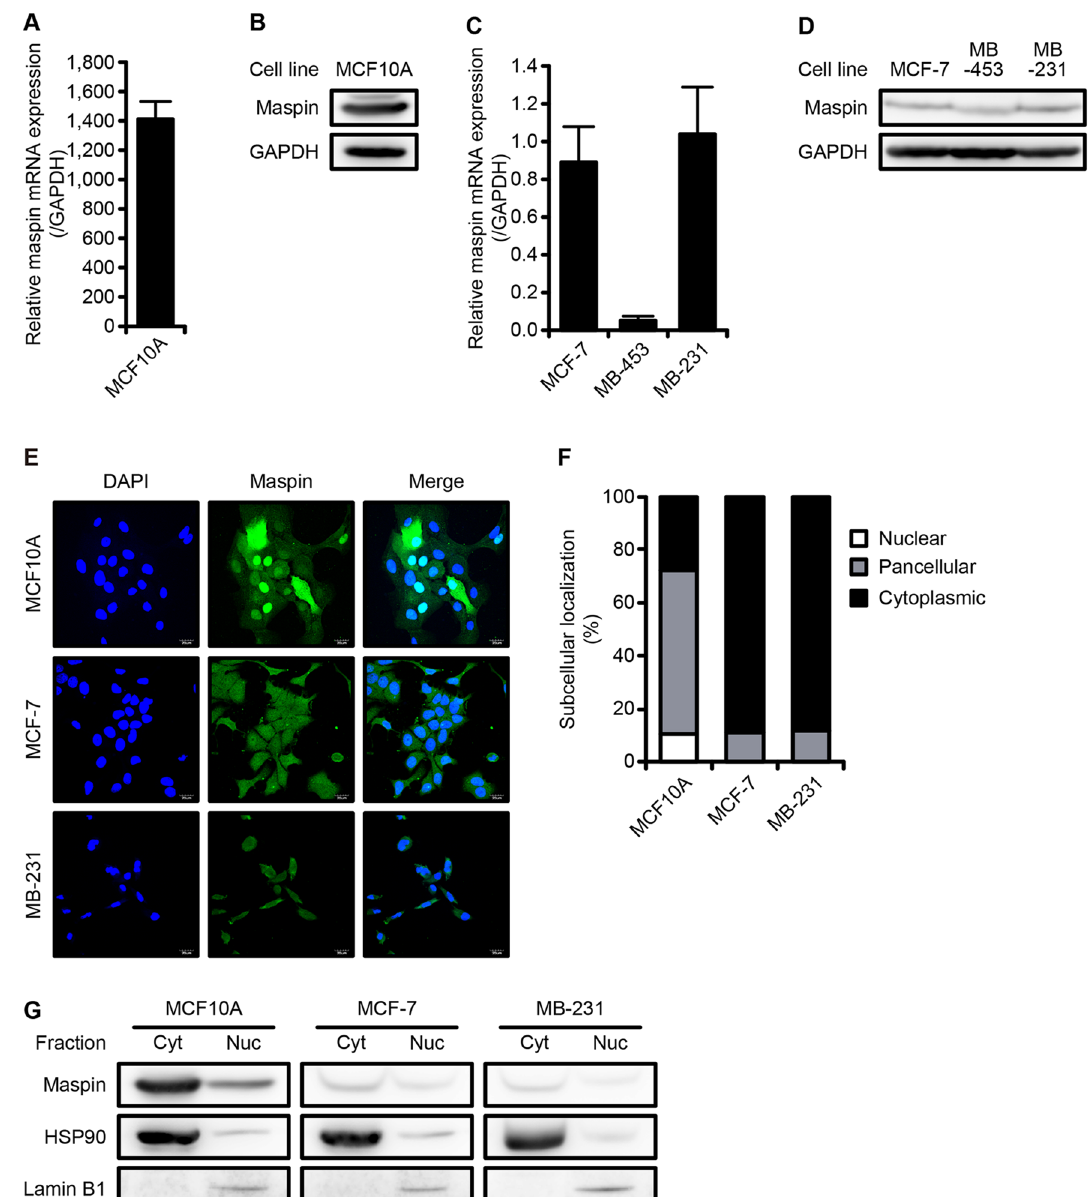
Figure 1. Expression and subcellular localization of maspin in non-tumorigenic and tumorigenic cell lines. ( A ) Relative mRNA expression level of maspin in MCF10A cells. mRNA expression was normalized to level of GAPDH . Data are shown as the mean ± SD ( n = 3). ( B ) Protein expression level of maspin in MCF10A cells. GAPDH is shown for loading control. Whole western blots are presented in Supplementary Fig. S7. ( C ) Relative mRNA expression levels of maspin in breast cancer cell lines. mRNA expression was normalized to levels of GAPDH . Data are shown as the mean ± SD ( n = 3). ( D ) Protein expression levels of maspin in three breast cancer cell lines. Expression level of GAPDH was used as a protein loading control. Whole western blots are presented in Supplementary Fig. S8. ( E ) Representative images of subcellular localization of maspin protein in MCF10A, MCF-7, and MDA-MB-231 cells. Expression of maspin protein was detected using anti-maspin antibody (clone G167-70). Nuclei was counterstained with DAPI. Scale bars represent 20 μm. Images were acquired using Olympus FLUOVIEW FV1000D confocal laser scanning microscope and Olympus FV10-ASW software (ver. 02.01). ( F ) Quantification of the subcellular localization of maspin. Bar graph shows the percentage of maspin distribution that is calculated by counting number of cells exhibiting pancellular, nuclear, or cytoplasmic distribution ( n = 3). ( G ) Protein expression of maspin in the cytoplasmic (Cyt) and nuclear (Nuc) fractions. Expression levels of HSP90 and Lamin B1 was used as protein loading control in the cytoplasmic and nuclear fractions, respectively. Whole western blots are presented in Supplementary Fig.